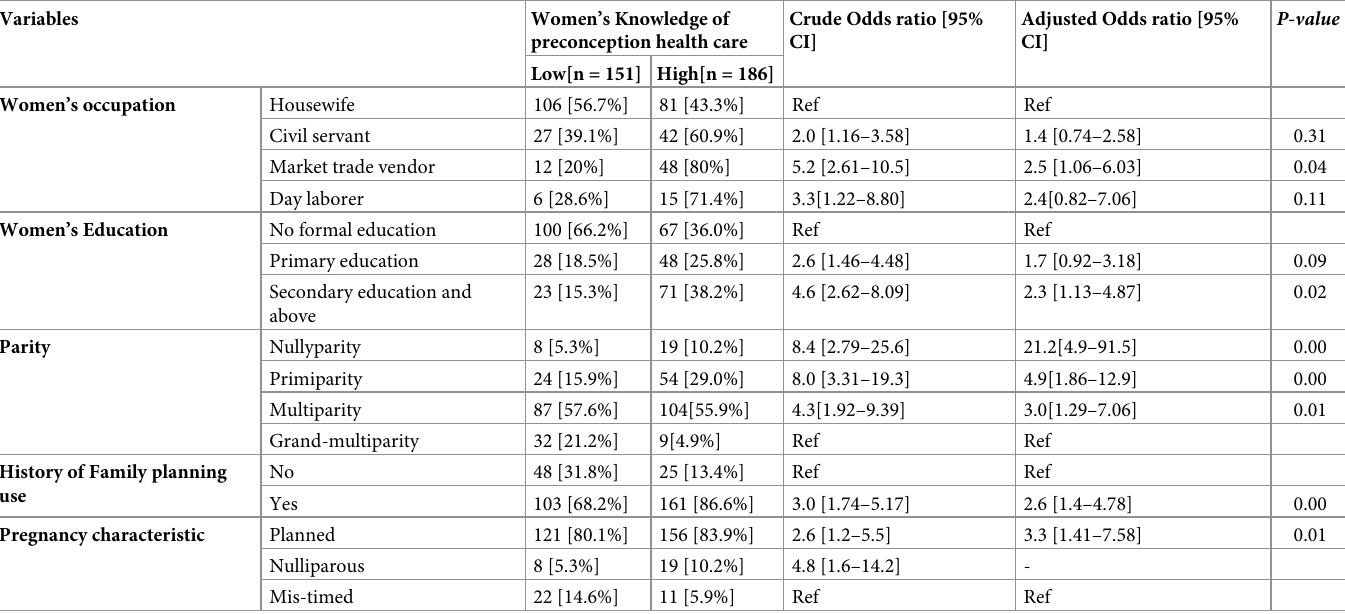
Table 4. Proportion, unadjusted and Adjusted comparison of knowledge of preconception care among married women in Jinka, Southern Ethiopia, 2018 [n = 337].